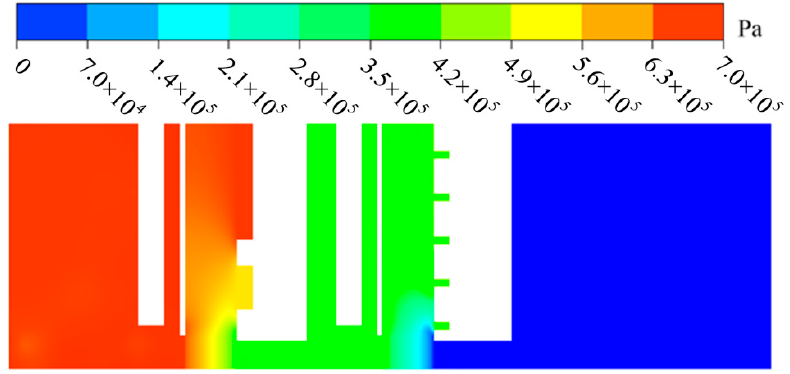
Figure 16. Pressure contour of 2SFS.